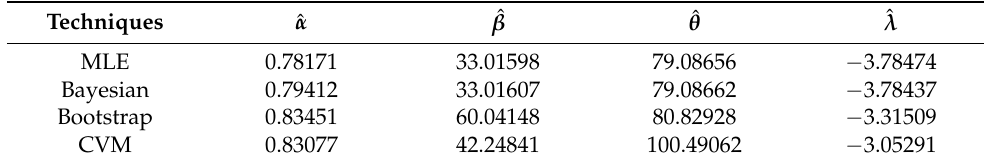
Table 14. The estimated parameters for the EGRRP under insurance-claims data.